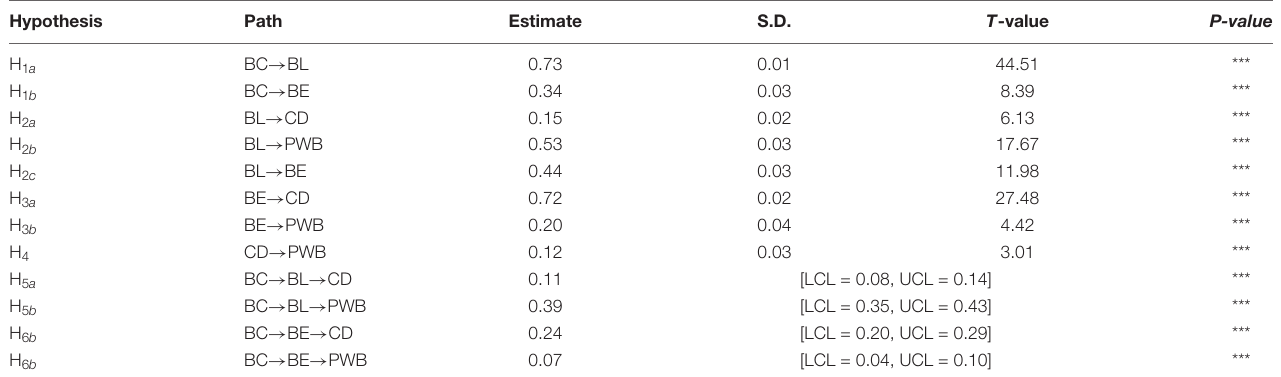
FIGURE 2 | Structural model. **Means p value < 0.00. TABLE 5 | Hypotheses